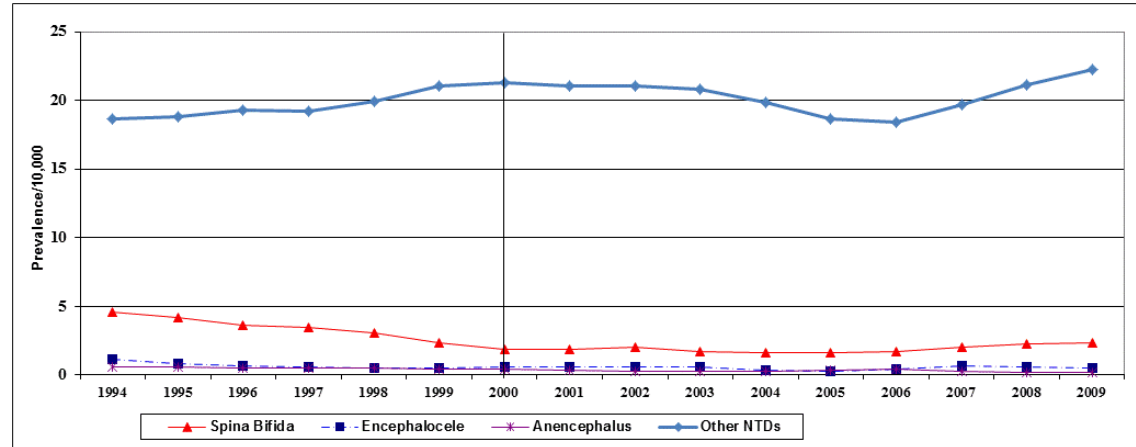
Figure 3. Birth prevalence (/10,000) of NTD sub-categories in Ontario, 1994 